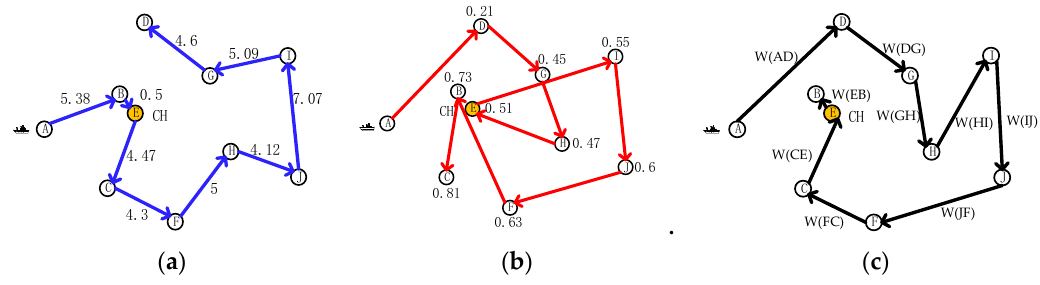
Figure 10. Path comparison of different recycling strategies. ( a ) Optimal path.; ( b ) Optimal energy; ( c ) KFNS algorithm.